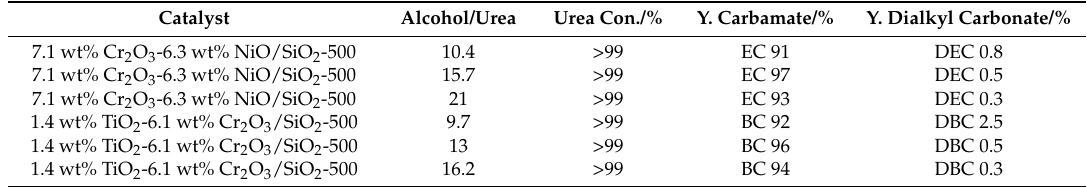
Table 4. Effect of molar ratio of ethanol/urea or butanol/urea on synthesis of EC or BC *. Catalyst